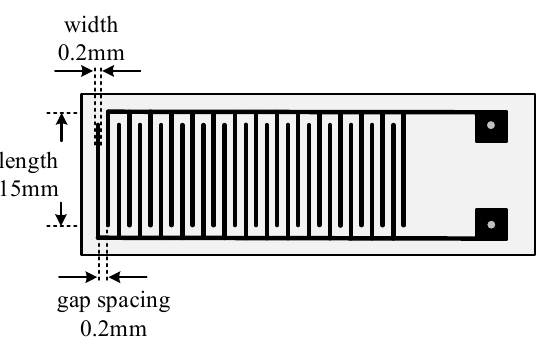
Figure 5. Schematic diagram of a PANI gas sensor.